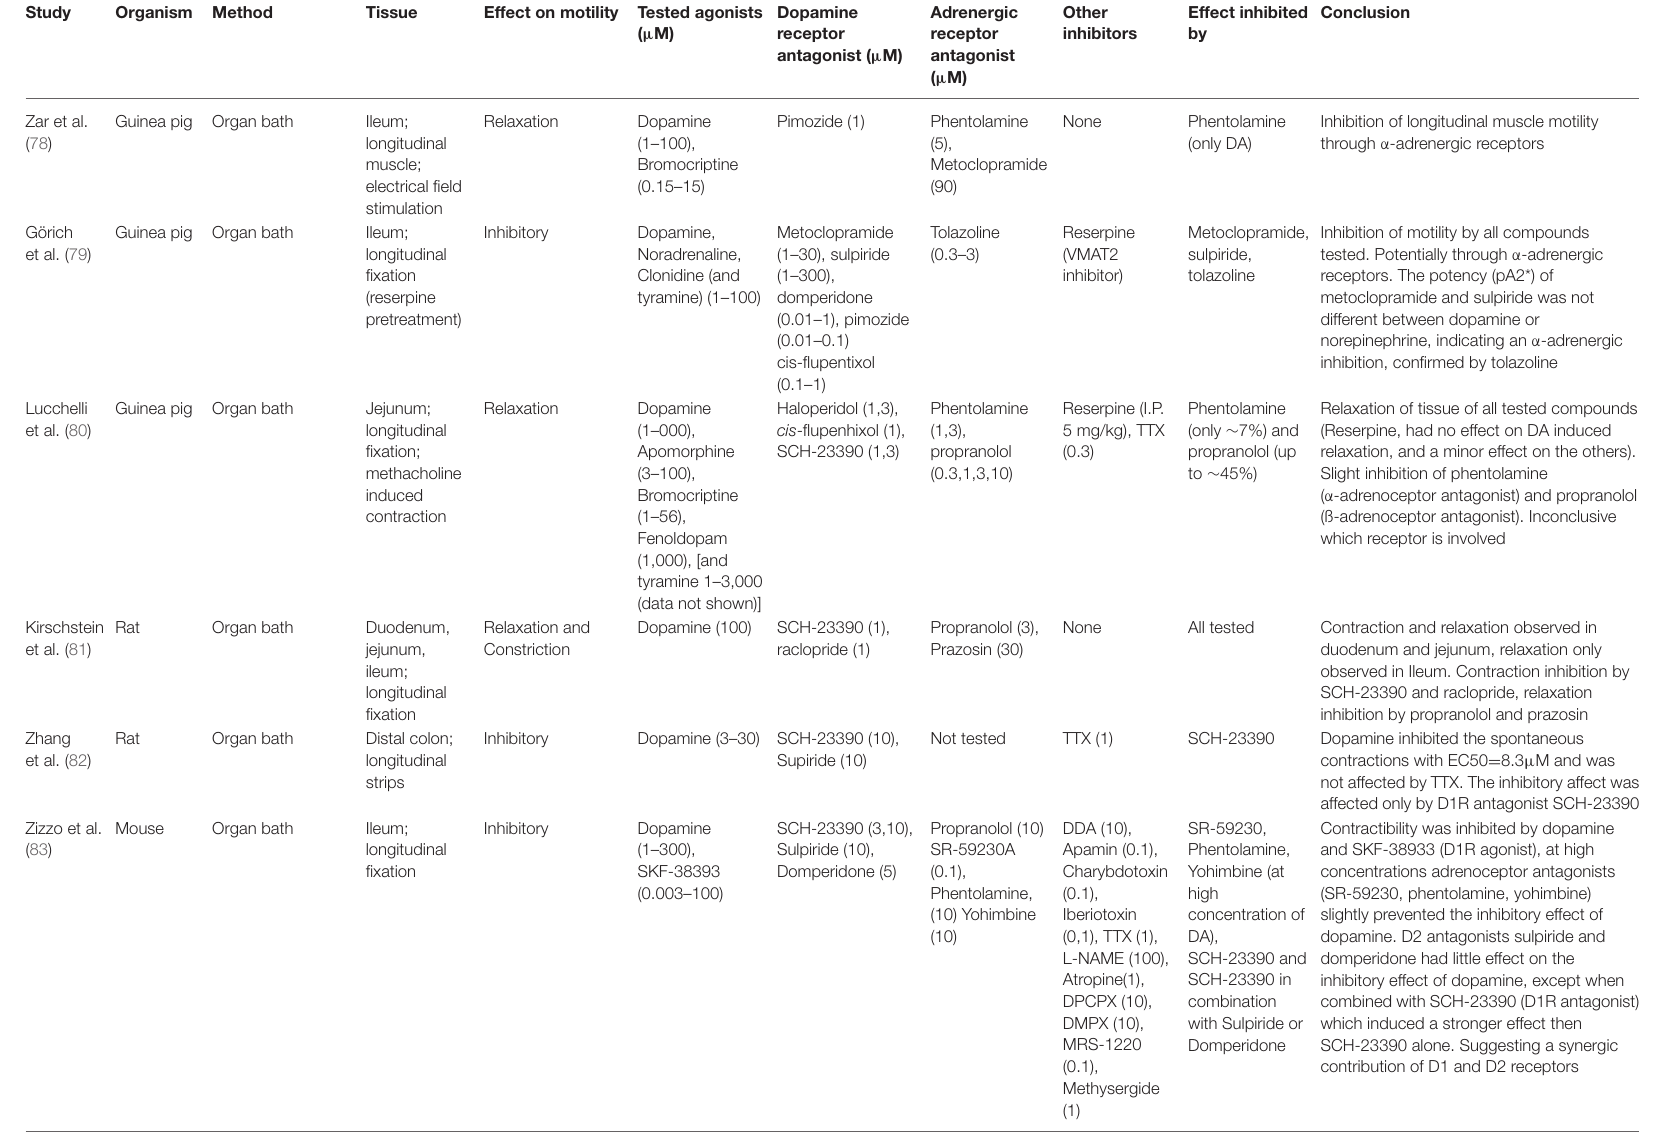
TABLE 1 | Studies investigating the effects of dopamine and dopamine agonists on gut motility in rodents, dogs and